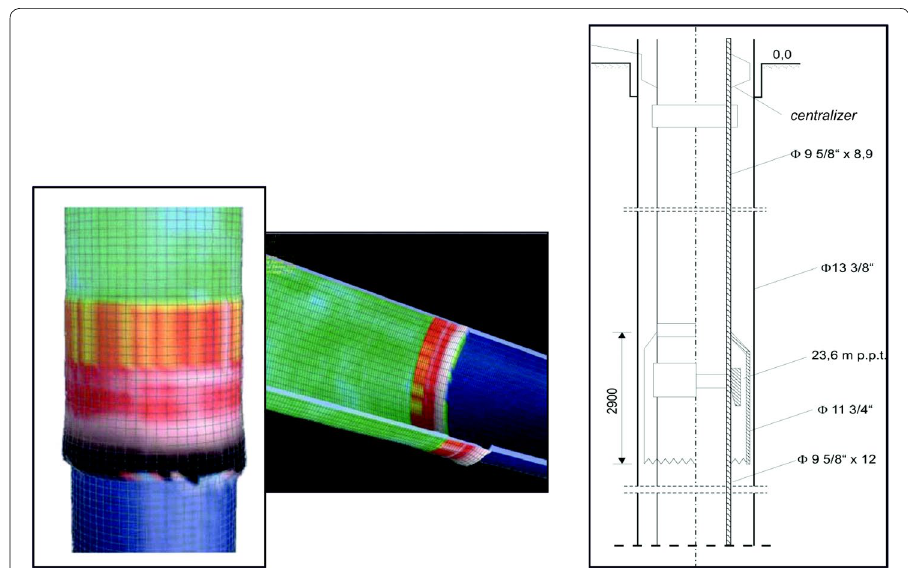
Fig. 5 Picture of casing repair at a depth of 23 m (left: casing joints—image from the MIT probe from 2003, right: supplementary casing design from 1999) (Bujakowski et al. 2013a)